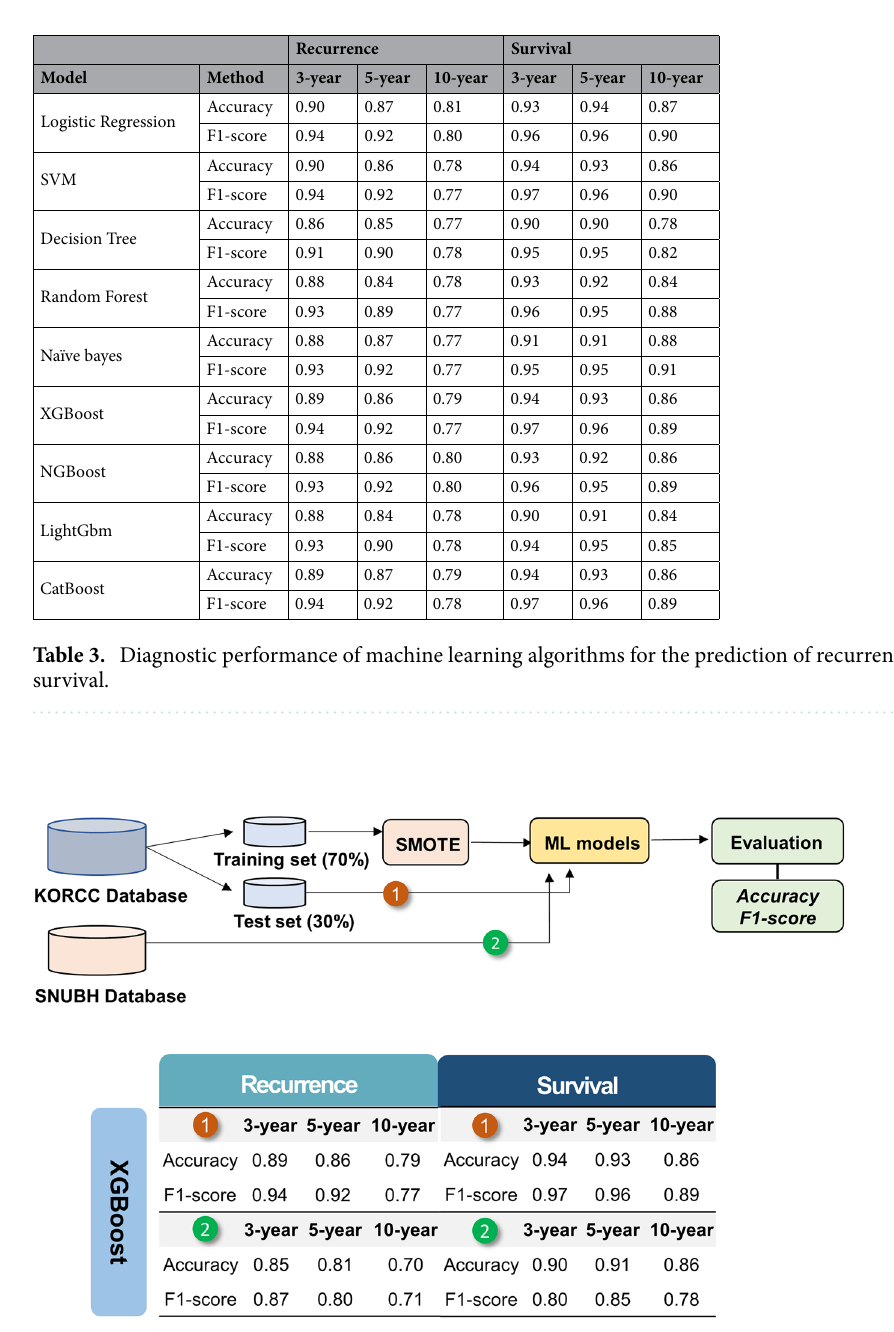
Figure 2. Compositions of database and results of (1) internal and (2) external validation for recurrence and survival.